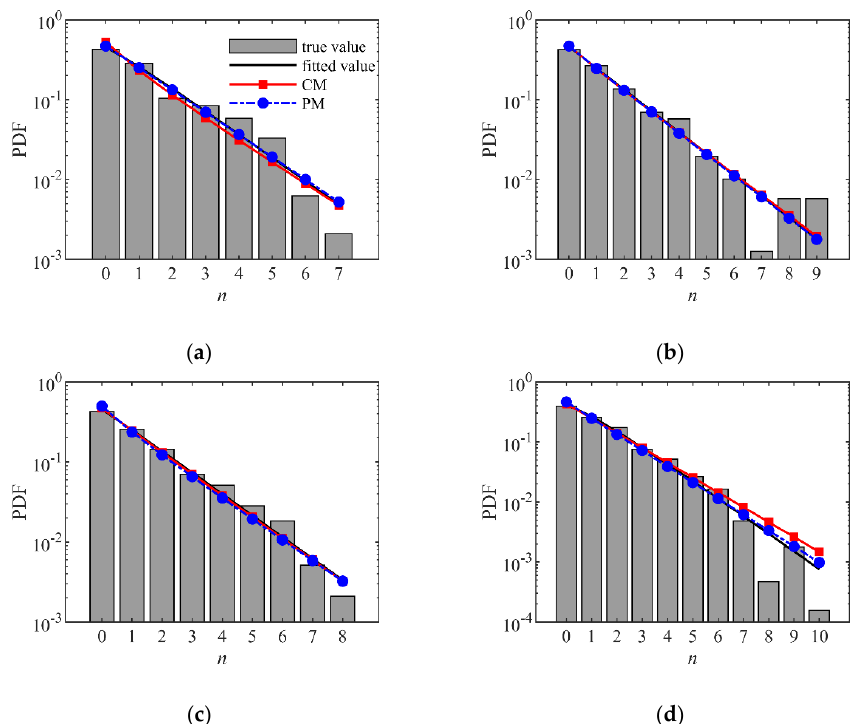
Figure 10. The probability density distribution of number of active particles in ( a ) C1, ( b ) C2, ( c ) C3 and ( d ) C4.